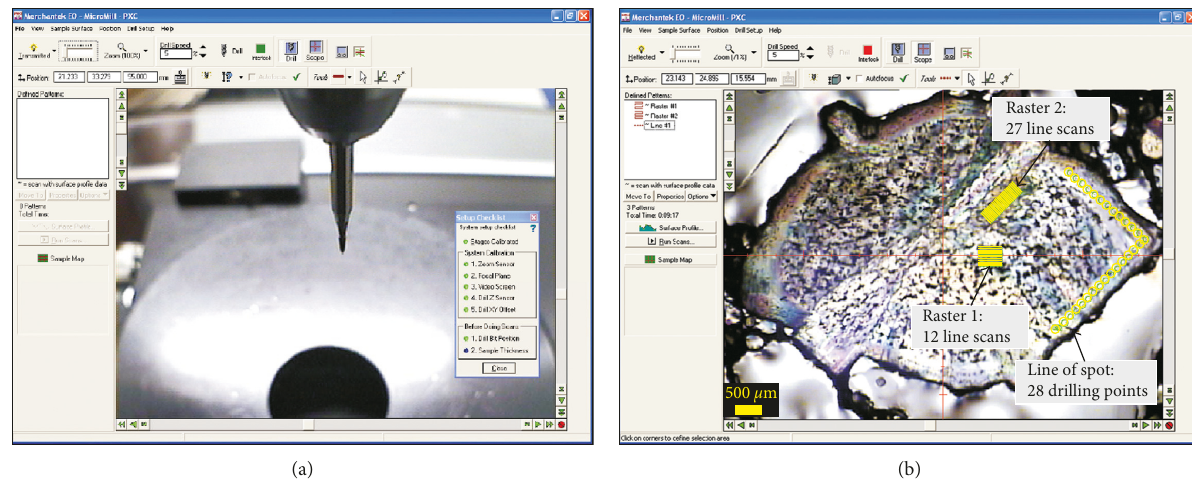
Figure 2: (a) Live image of the sample stage and drill bit shown by the digital camera placed next to the milling chuck; (b) microscope view image showing a zoned plagioclase crystal with drilling pattern. Two rasters (in yellow) are set up to drill the plagioclase core, whereas a line of spot is set up for the rim